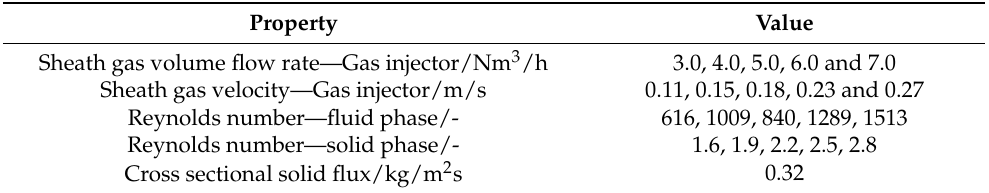
Table 2. Different operating conditions for the particle residence time